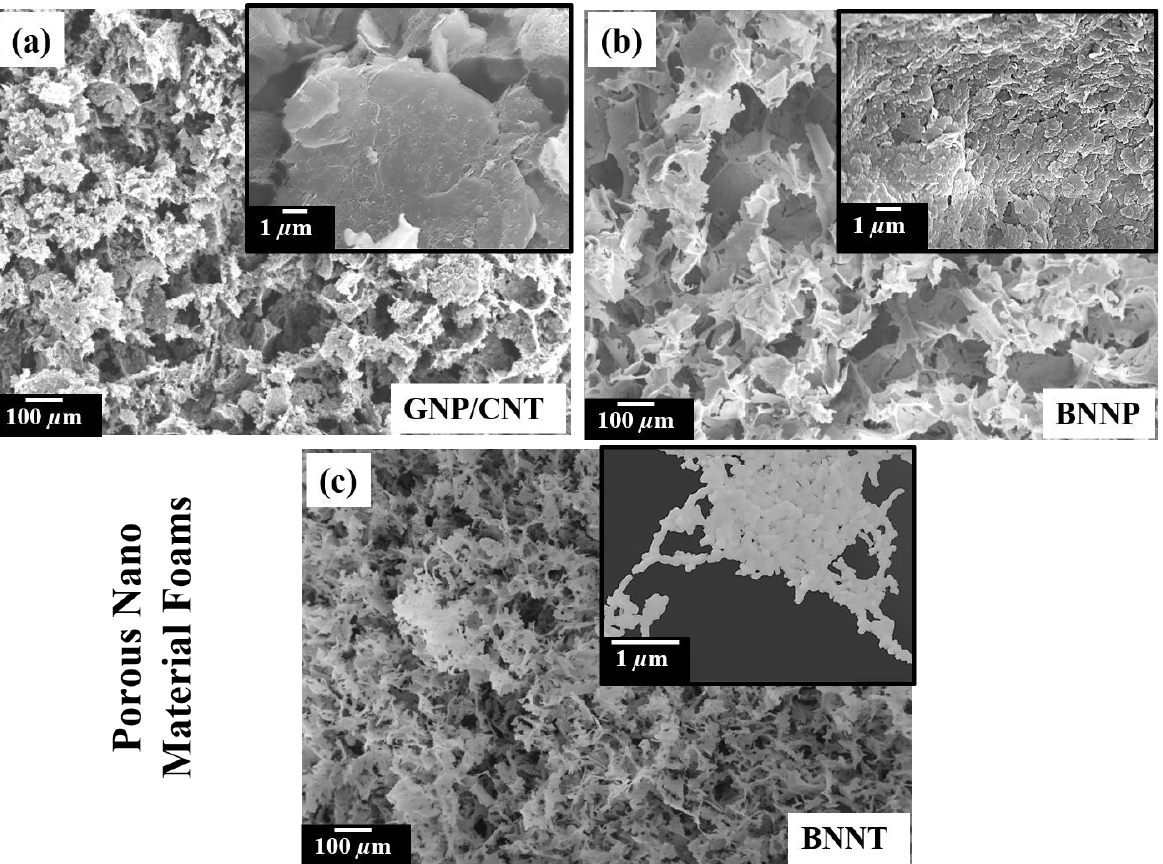
Figure 11 . Porous 3D Foam produced by FD: ( a ) GNP/CNT composite foam; ( b ) BNNP foam; and ( c ) BNNT foam. Insets show the wall features of the foams .